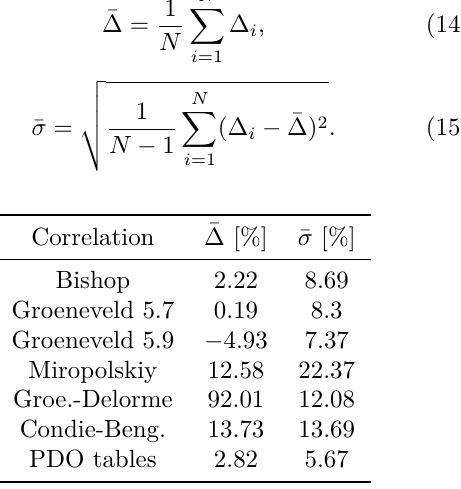
Table 3. Statistical evaluation of post CHF correla- tions.